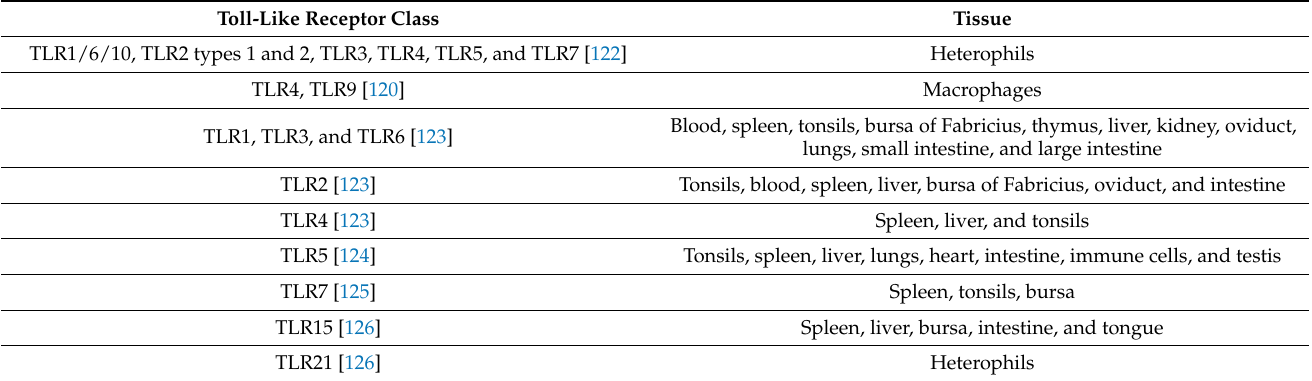
Table 4. Toll-like receptors on different tissues and cell types of